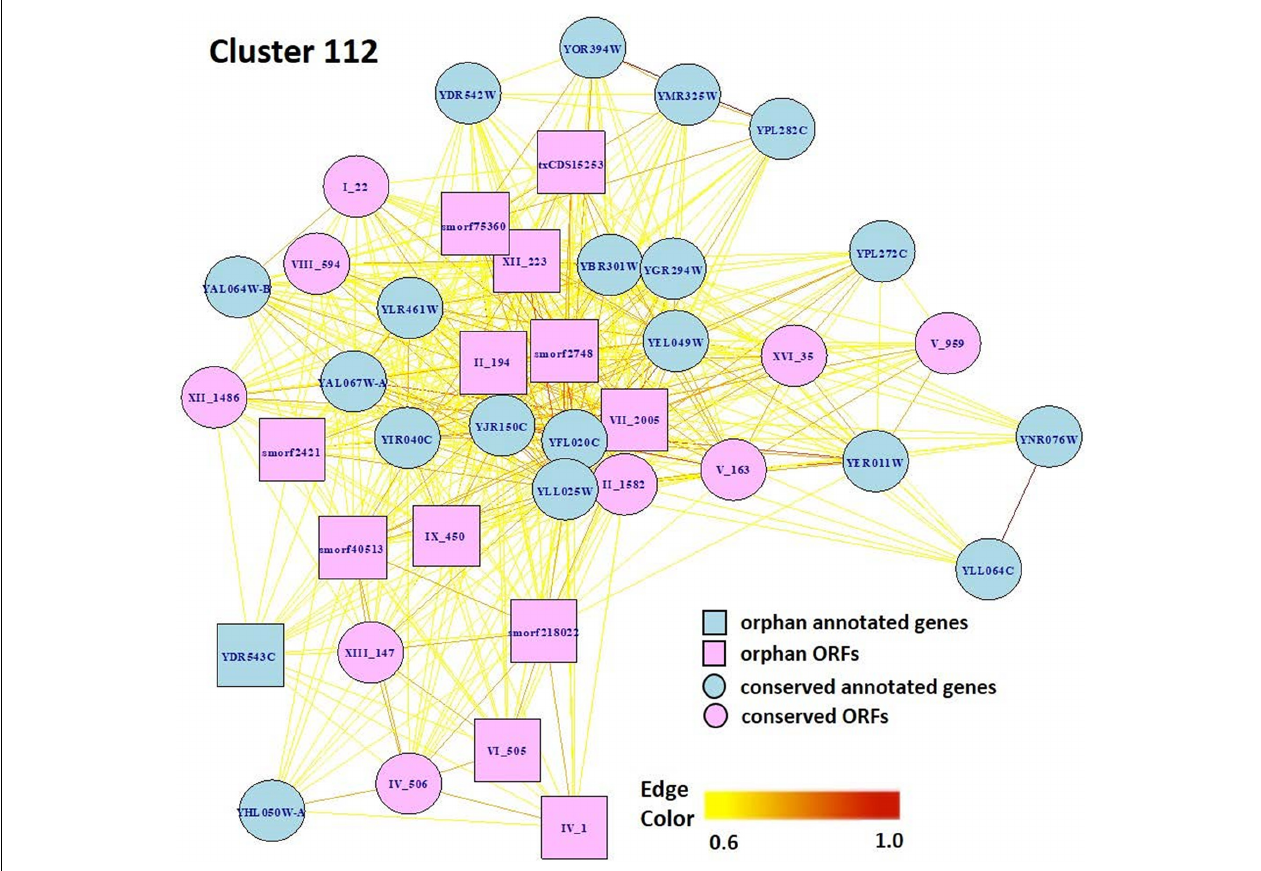
FIGURE 8 | Network view of genes and ORFs in Cluster 112, a cluster enriched in seripauperins and other stress-responsive genes. A Pearson correlation matrix of the SGD+ORF dataset was partitioned into clusters by MCL. Edge colors, Pearson correlations(0.6–1.0). Visualization by igraph in R (Csárdi and Nepusz, 2006).